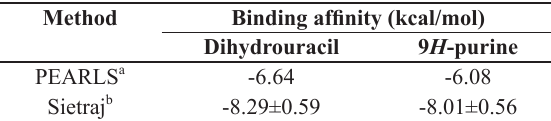
Binding affinities of dihydrouracil and 9 H -purine to the putative phosphoribosyltransferase (PPTM) from Meloidogyne incognita